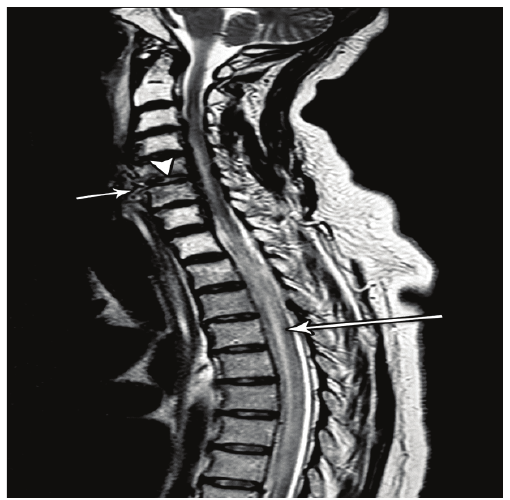
Figure 1: Postcontrast sagittal CT demonstrating air in the prever- tebral space (short arrow) and spinal canal (long arrow). Figure 2: Sagittal T2 MRI demonstrating small collection in the prevertebral space (short arrow) with extension through C5-6 intervertebral disk space (arrow head) and edematous and abnormal high signal of the spinal cord (long arrow).